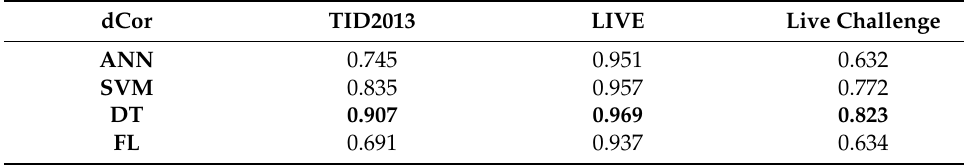
Table 6. Brownian’s distance between the group of intermediary metrics and MOS.